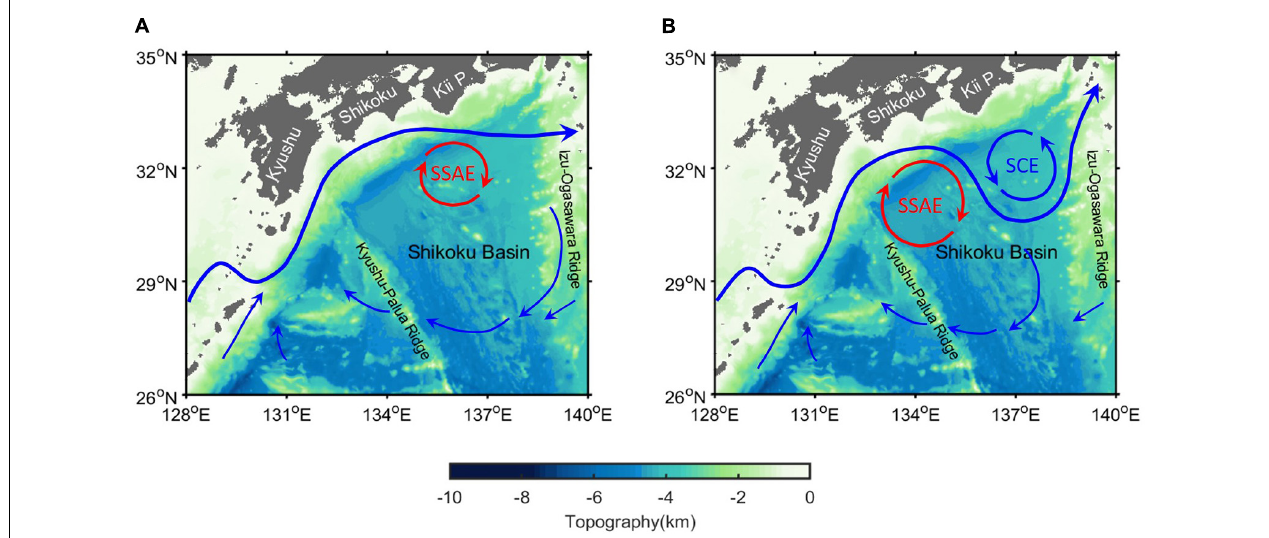
FIGURE 1 | Schematic diagrams of the sea surface currents (blue curves) and topography (color) for the (A) NLM and (B) LM paths in the region off the southern coast of Japan. The subsurface anticyclonic eddy (SSAE) and enhanced surface (SCE) cyclonic eddy associated with the formation of the LM path are indicated by red and blue curves,